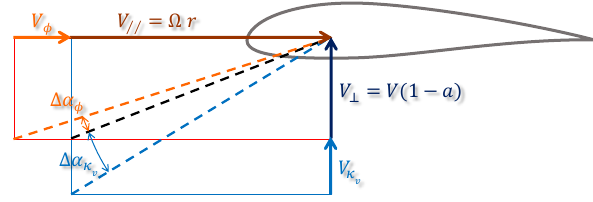
Figure 9. Effects of shear and misalignment changes on sectional angle of attack.